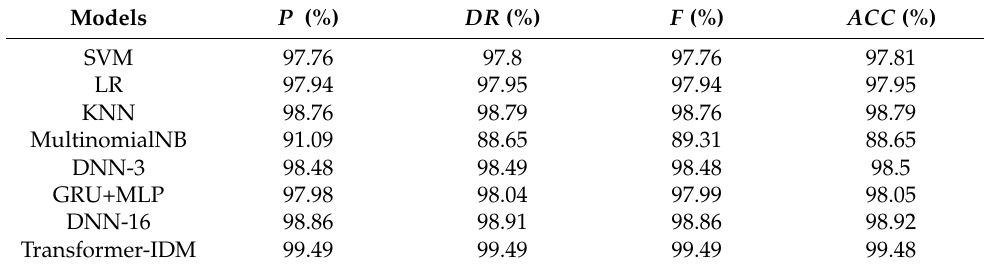
Table 6. The values of evaluation